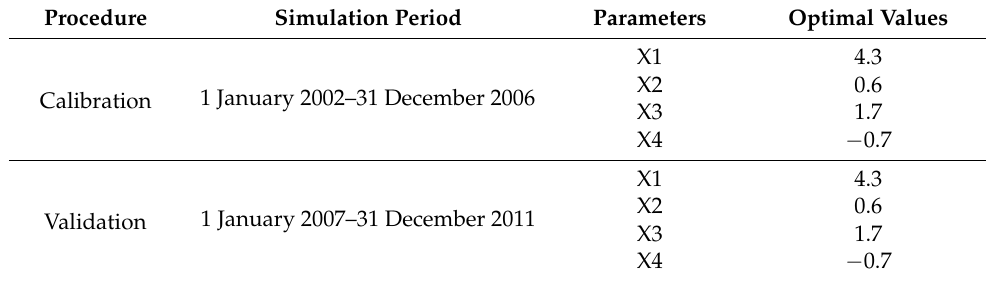
Table 1. Optimal values of the model parameters (GR4J).